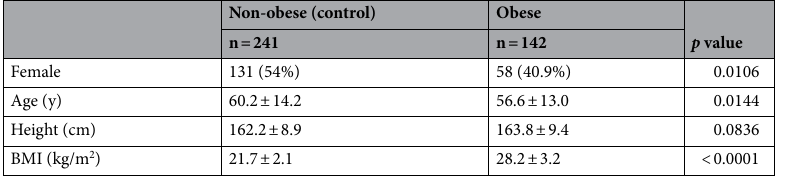
Table 1. Patients characteristics. In the obese group, the range was 25–40.2 kg/m 2 , and in the non-obese group, the range was 14.6–24.9 kg/m 2 . BMI, body mass